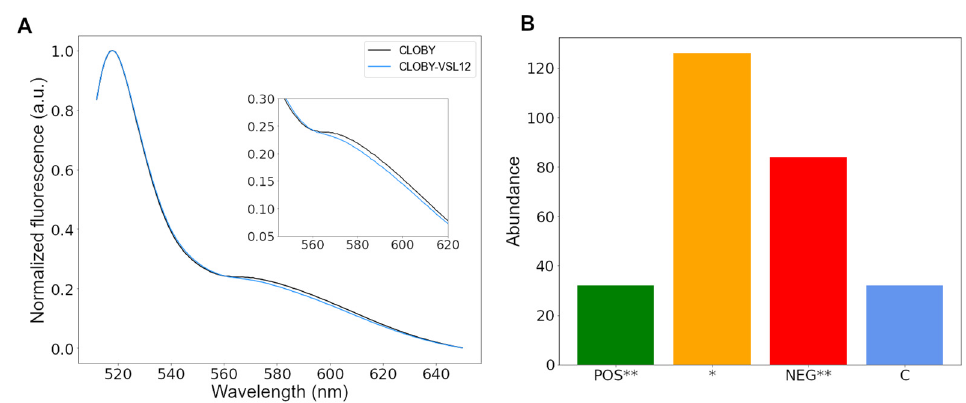
Figure 4. ( A ) CLOBY FRET is decreased in the presence of the VLS12 peptide, known to disturb the fuzzy complex of the SNRE. ( B ) Statistics of the first screening results based on fluorescence changes at 530 nm. Green and red bars represent the number of compounds increasing or decreasing the fluorescence by more than 3 standard deviations (indicated by **), respectively, only in intact CLOBY. The blue bar corresponds to colored compounds that could not be analyzed in the high-throughput assay. Orange bar corresponds to compounds with an effect (positive or negative) between one and two standard deviations (indicated by *).